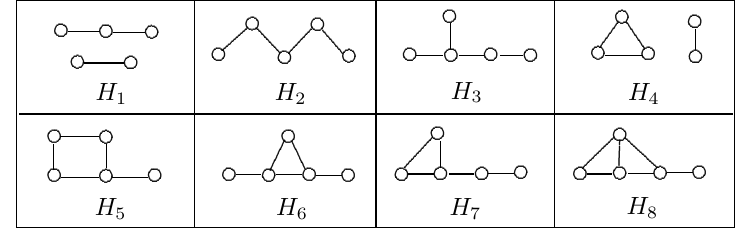
Figure 6: Eight graphs of order 5.